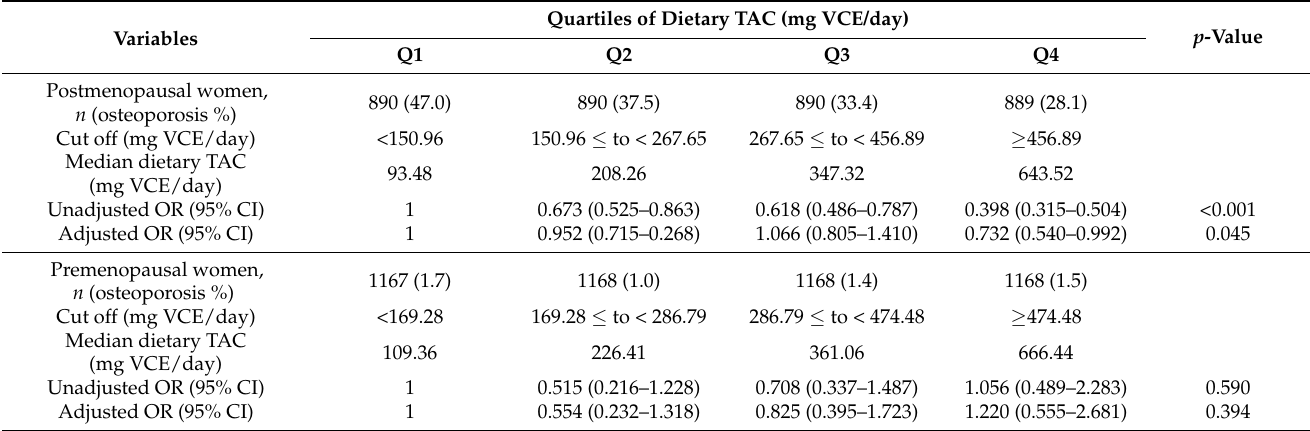
Table 2. Associations between dietary total antioxidant capacity (TAC) and the risk of osteoporosis in the study population. Variables